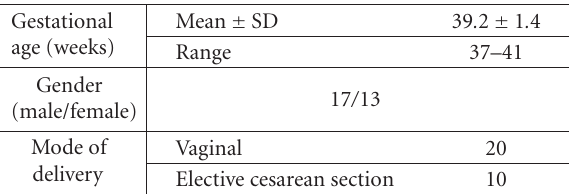
Table 1. Demographic data of participating full-term ( n = 30)